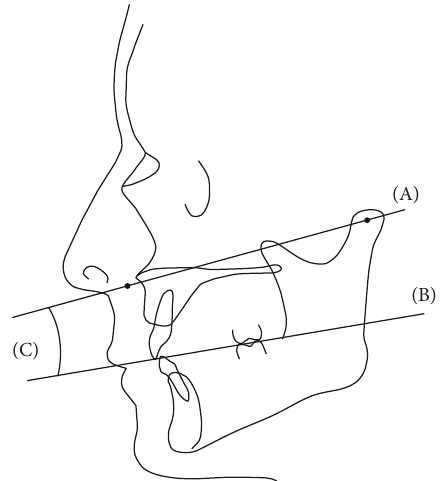
Figure 1: The morphological reference plane and the maxillary occlusal plane. (a) Morphological reference plane; the bilateral arbitrary hinge positions and the inferior margin of the nasal wing. (b) Maxillary occlusal plane; the incisal edge of the maxillary central incisor to the distobuccal cusp on bilateral maxillary first molars. (c) The angle formed by the morphological reference plane and the maxillary occlusal